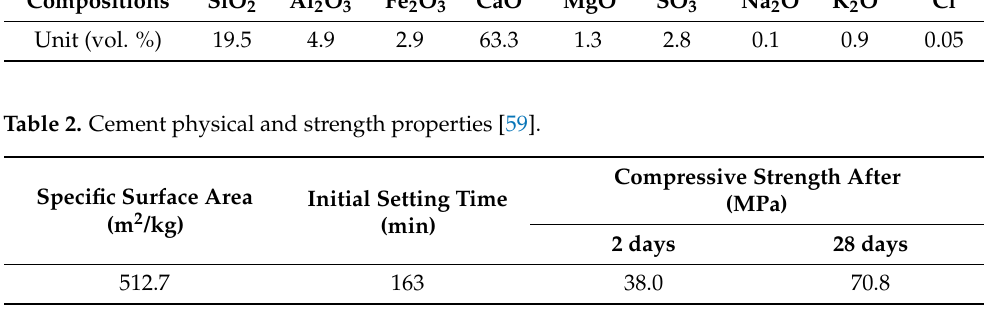
Table 1. Cement chemical composition [59].